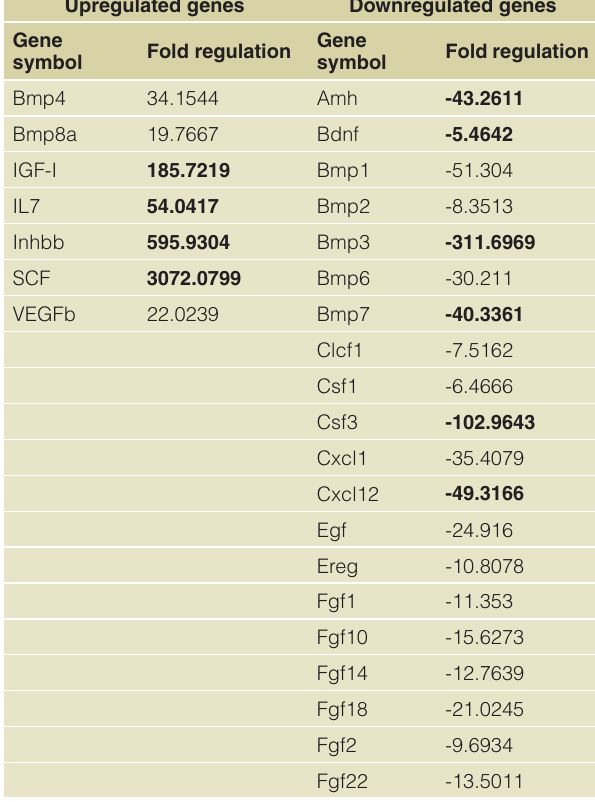
Table 3. Growth factors